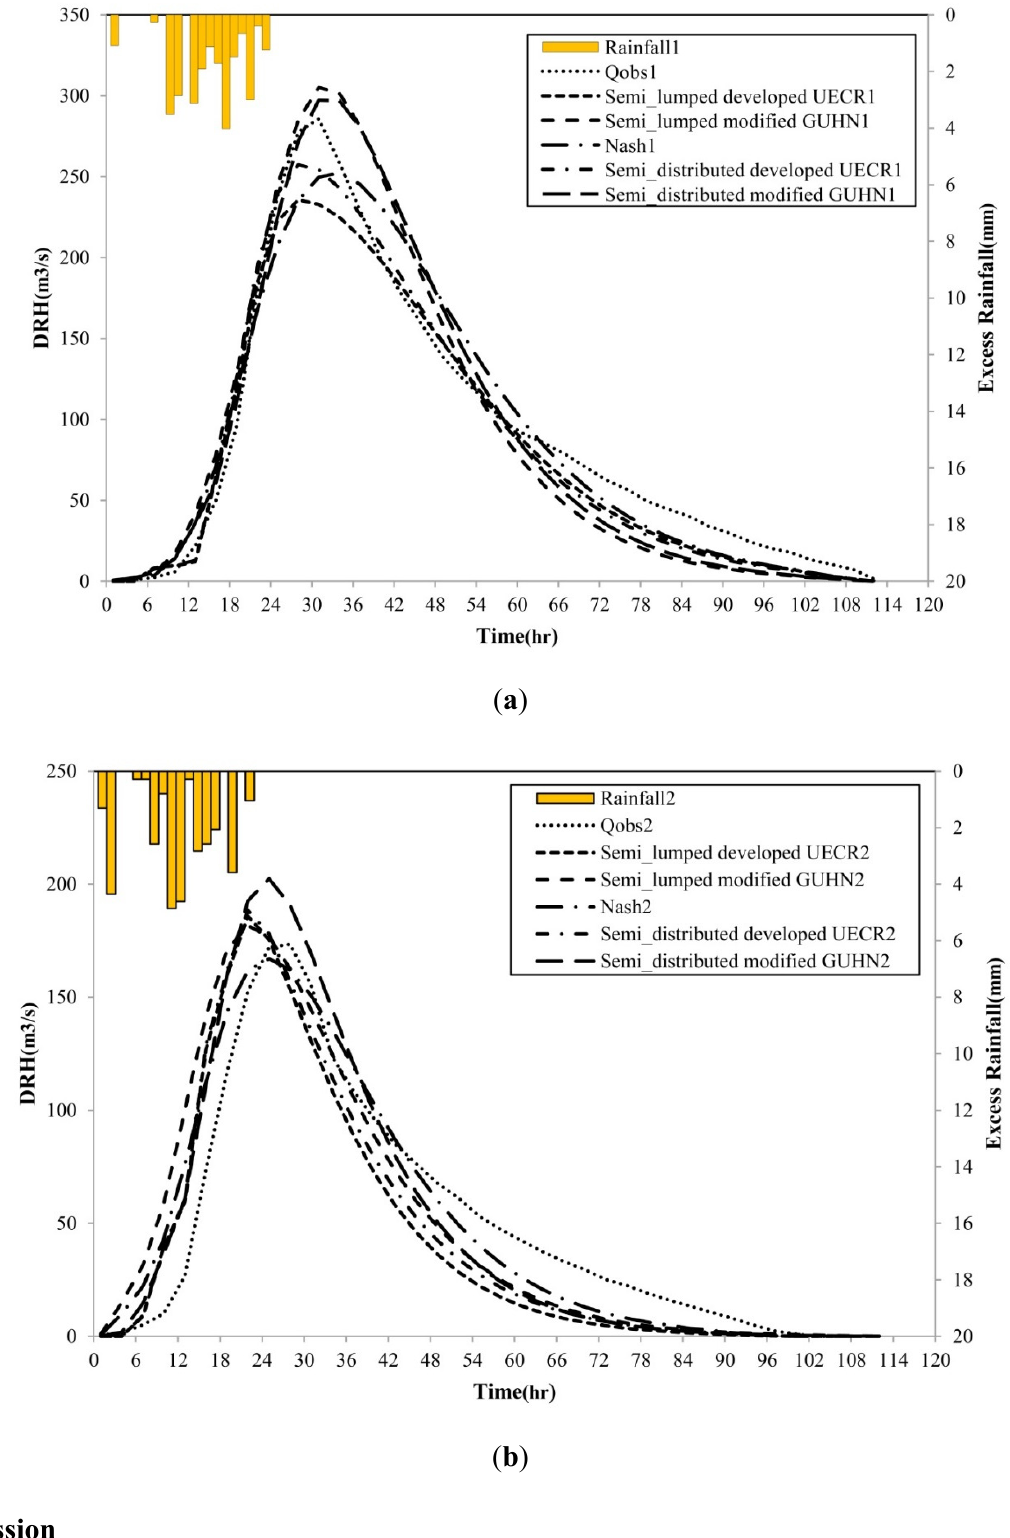
Figure 5. Verification graphs of Nash, modified GUHN and developed UECR models. ( a ) Event 23 February 2008 at Outlet 1; ( b ) Event 23 February 2008 at Outlet